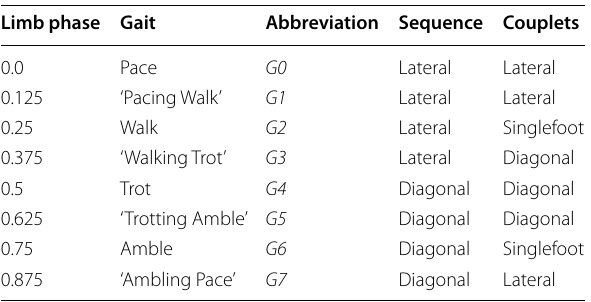
Table 1 Gaits are conventionally defined by the timing of the footfall